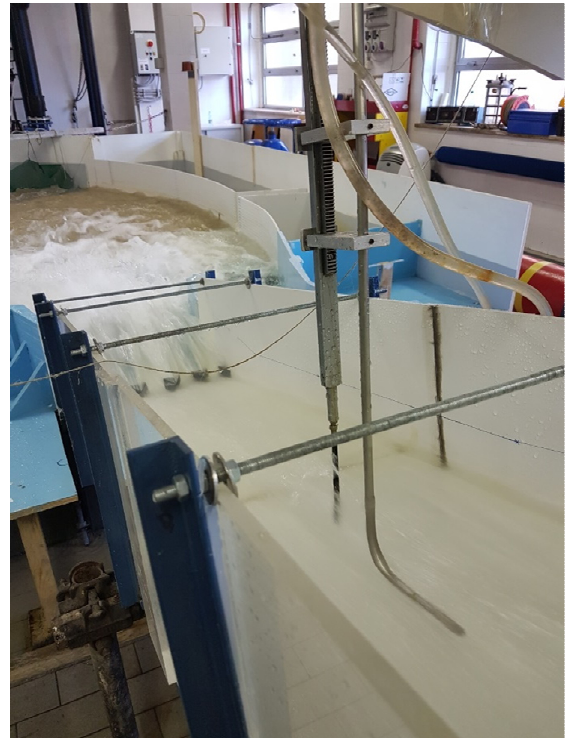
Figure 9. Pitot tube placed at (roughly) half the chute length. These measurements were performed at a discharge rate of 1450 m 3 /s, i.e., the design flow rate for the hydraulic structure. The velocity profiles in two different points were measured: